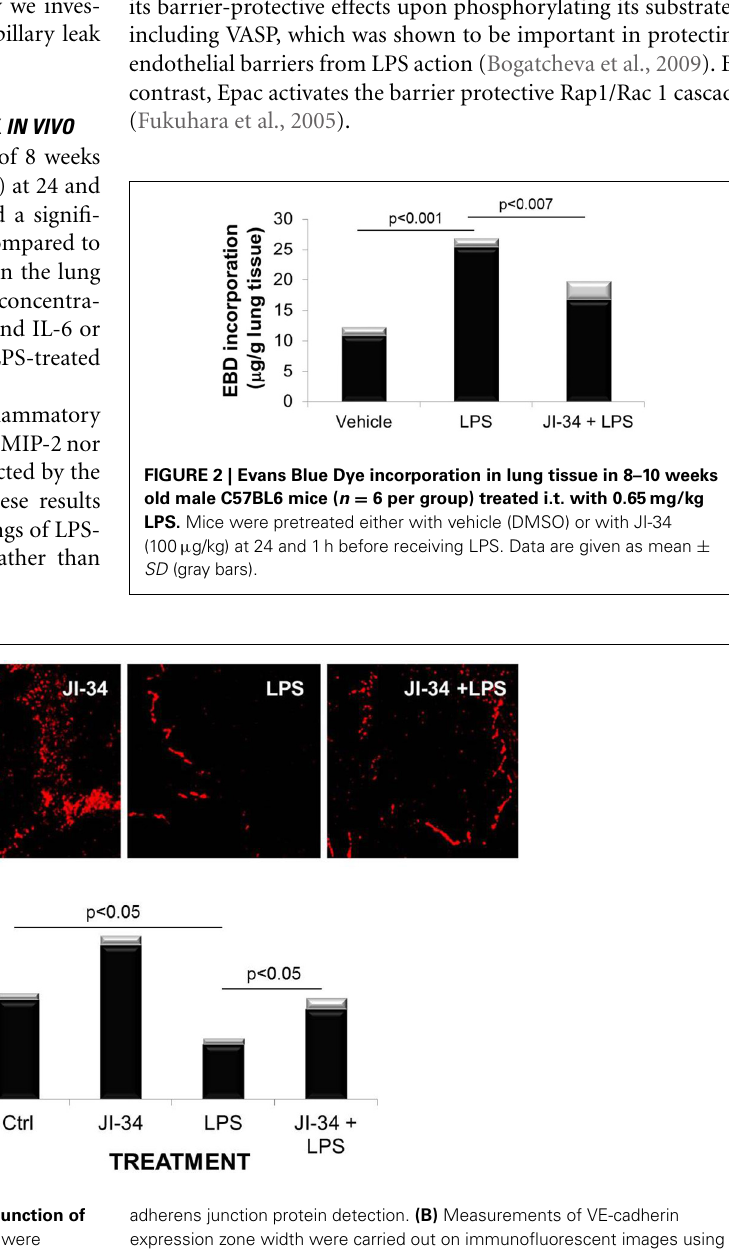
adherens junction protein detection. (B) Measurements of VE-cadherin expression zone width were carried out on immunofluorescent images using ImageJ software. Mean of VE-cadherin zone width are presented as ± SD (gray bars) ( n = 100 for each experimental